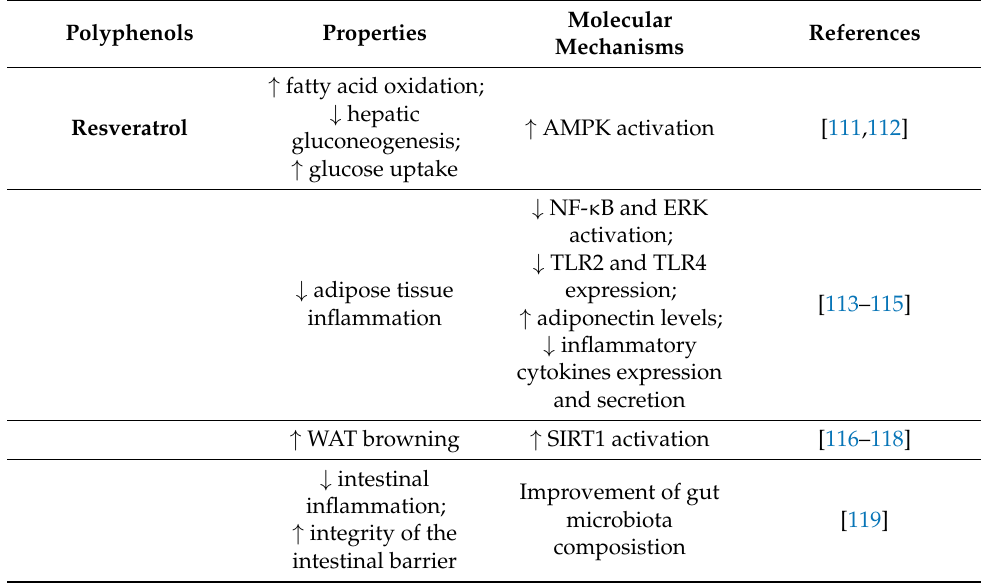
Table 1. Schematic representation of Citrus polyphenols effects on inflammation and metabolic alterations associated with